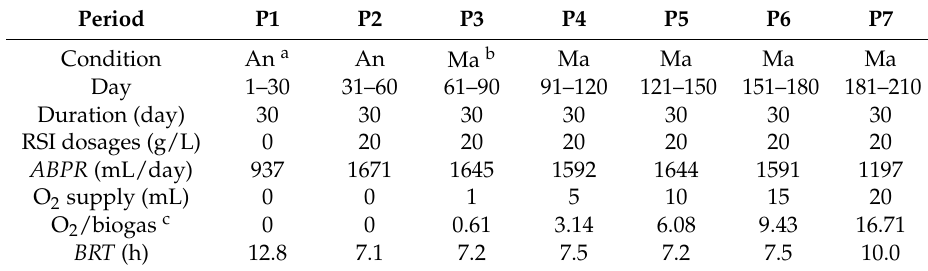
Table 2. Experimental parameters and results during semi-continuous anaerobic and microaerobic digestion of activated sludge supplemented with RSI over seven periods of operation associated with stepwise increases in oxygen concentration. RSI: rusty scrap iron; ABPR : Average biogas production rate; and BRT : biogas residence